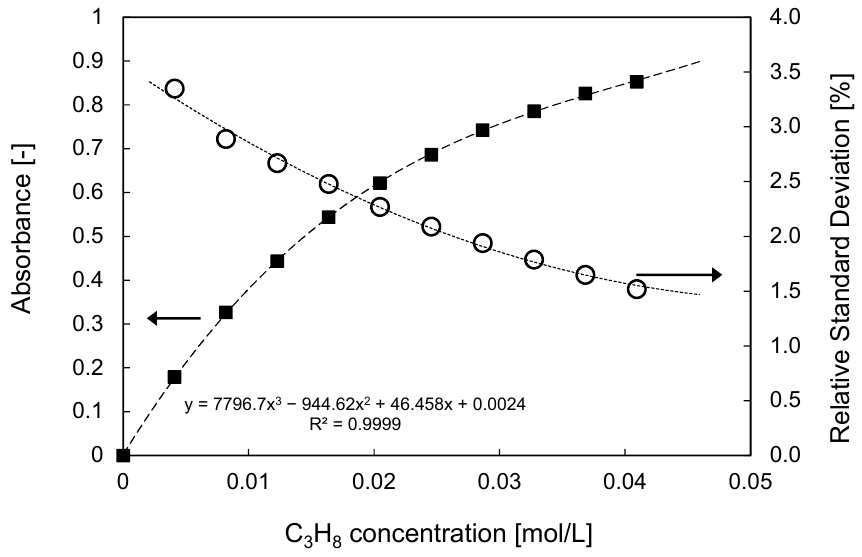
Figure 7. Single gas phase C 3 H 8 calibration for different gas mixtures using the optimized IR technique and standard deviation over the measurements for different concentrations. Coefficients for the fitting of the calibration are also given.